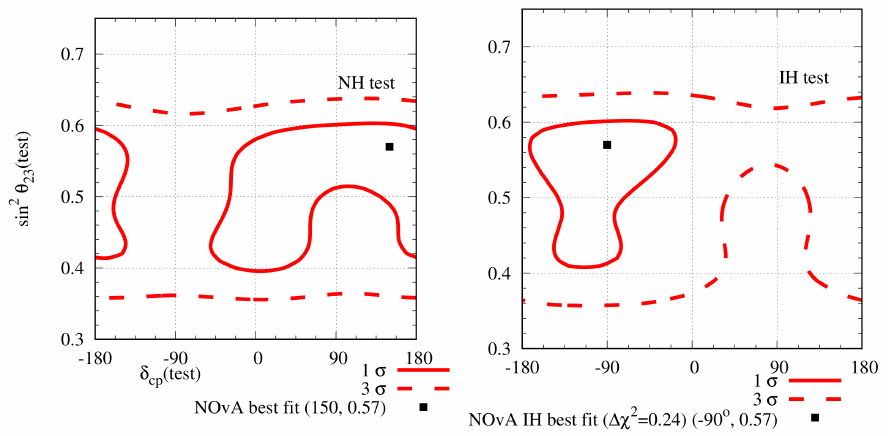
Figure 4. Expected allowed regions in the sin 2 θ 23 − δ CP plane from the NO ν A appearance data, as given in Ref. [52,53], for both the ν e and ¯ ν e channels. In the left ( right ) panel, the hierarchy is assumed to be NH (IH). The best-fit point is at NH with a minimum χ 2 = 6.77 for 12 energy bins. IH has a minimum ∆ χ 2 =